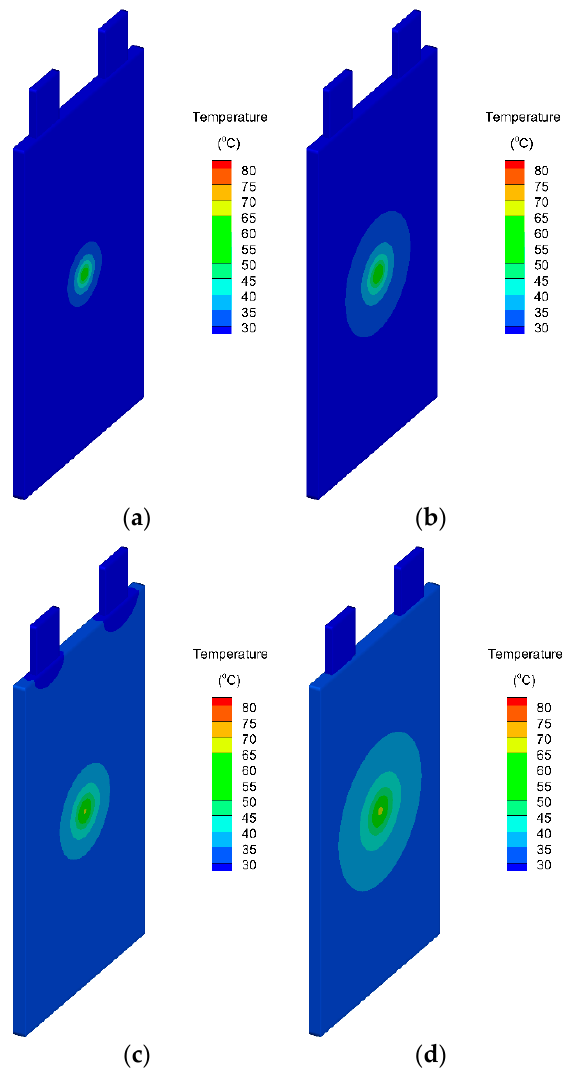
Figure 7. Temperature distributions of lithium-ion battery under internal shorting by 0.02 Ω after periods of ( a ) 15 s; ( b ) 30 s; ( c ) 45 s; ( d ) 60 s.